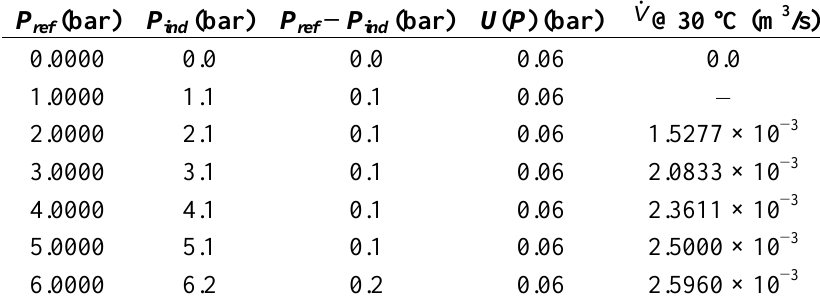
Table 1. Results of the ejector